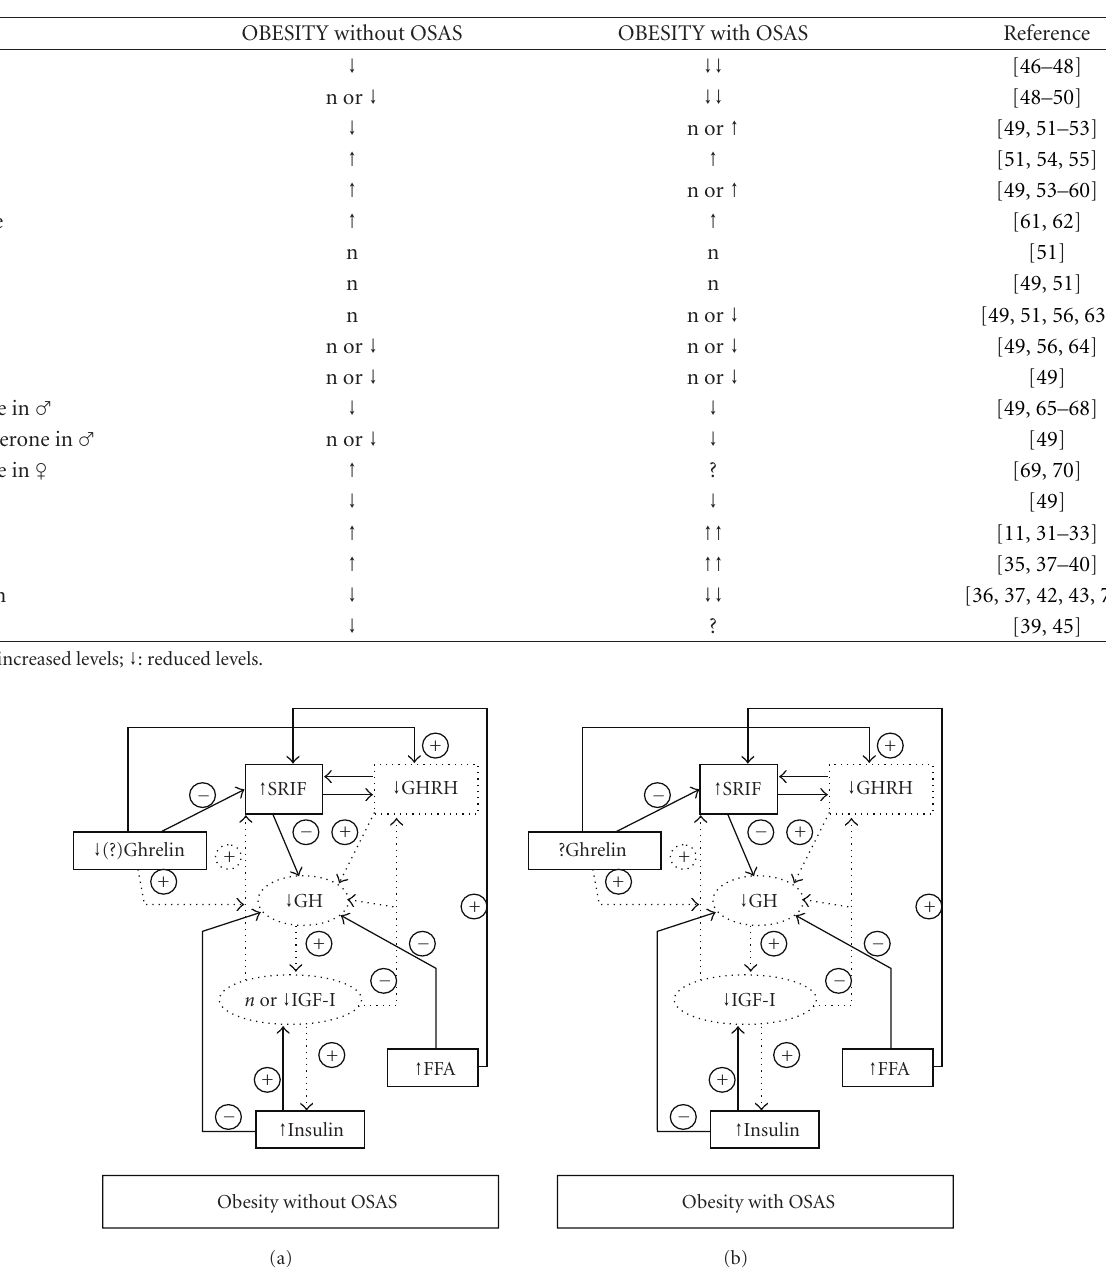
Table 1: Main hormonal changes in obesity and obstructive sleep apnea syndrome (OSAS).